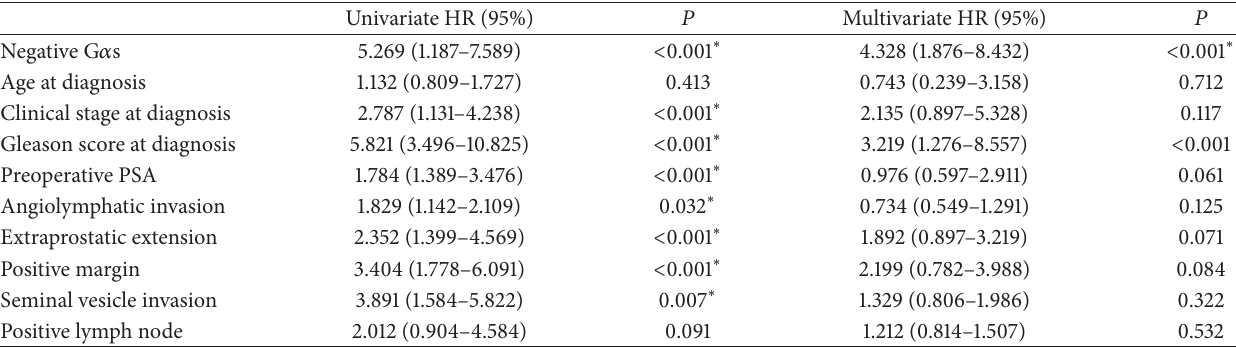
Table 6: Univariate and Multivariate analysis of clinical factors in relation to PSA progression-free survival. Univariate HR